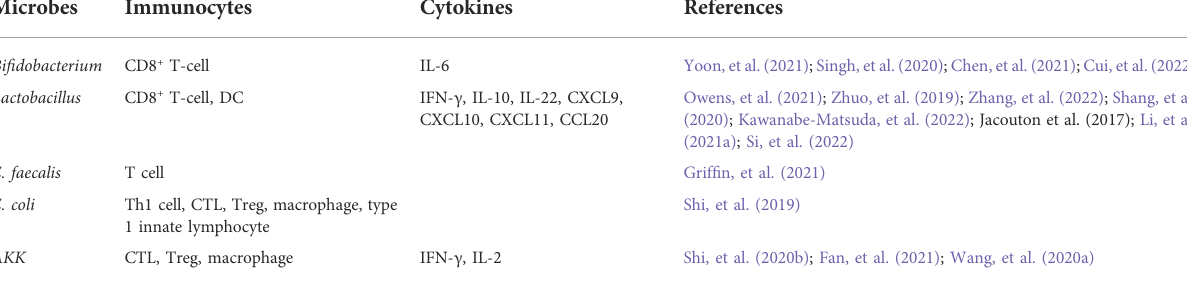
TABLE 1 In fl uence of intestinal microorganisms on the immune microenvironment of colorectal tumors.